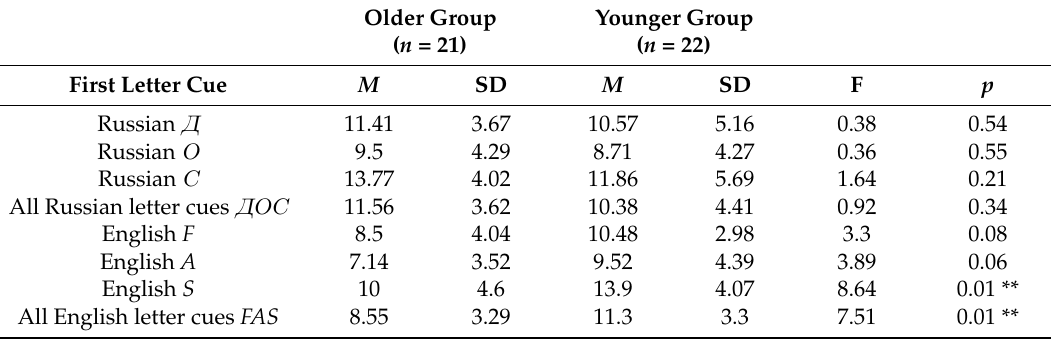
Table 4. Mean number of Russian and English words produced by participants of the older group and the younger group for each of the three letter fluency